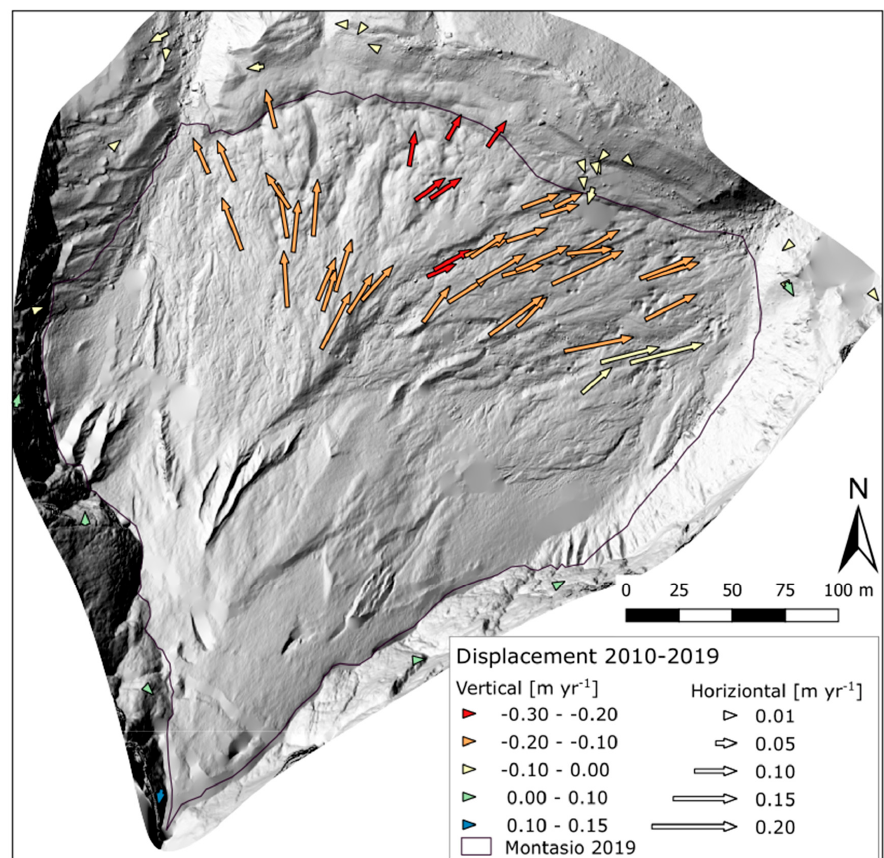
Figure 7. Displacement rates in the period from 2010 to 2019. Arrow lengths show horizontal displacement, whereas colors show vertical displacement. The arrow length used in this image is arbitrary and does not display the real horizontal cumulated displacement. Water 2020 , 12 , x FOR PEER REVIEW